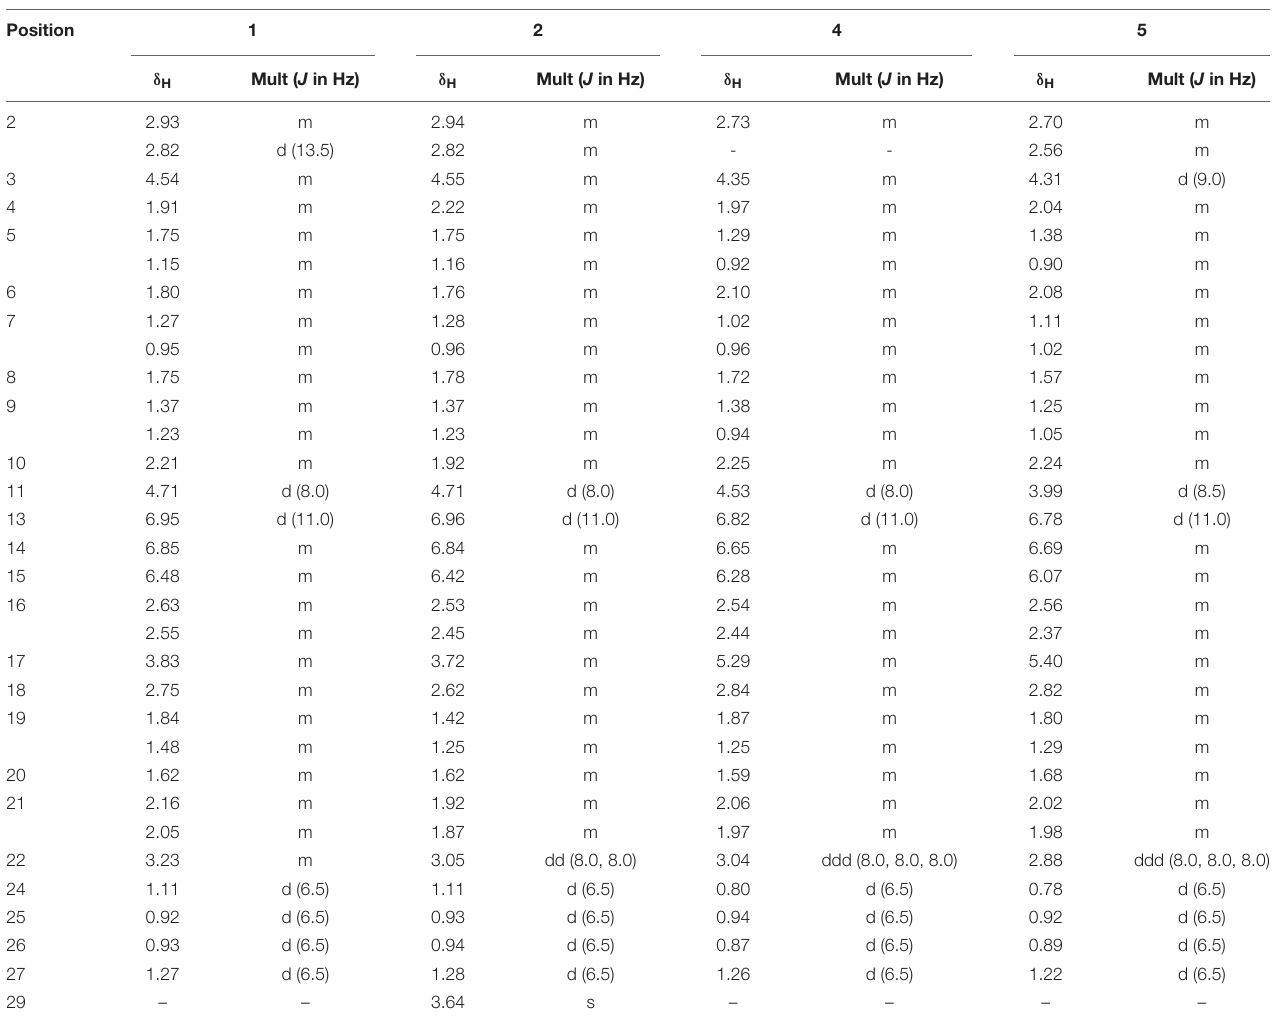
TABLE 1 | 1 H NMR (600 MHz) data for 1 , 2 , 4 , and 5 in pyridine- d 5 .